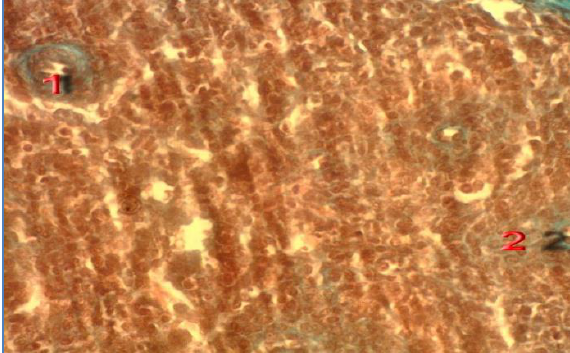
Figure, 5: At 7 day after hatching showing 1. PALS and 2.PVLS, Masson Trichrome